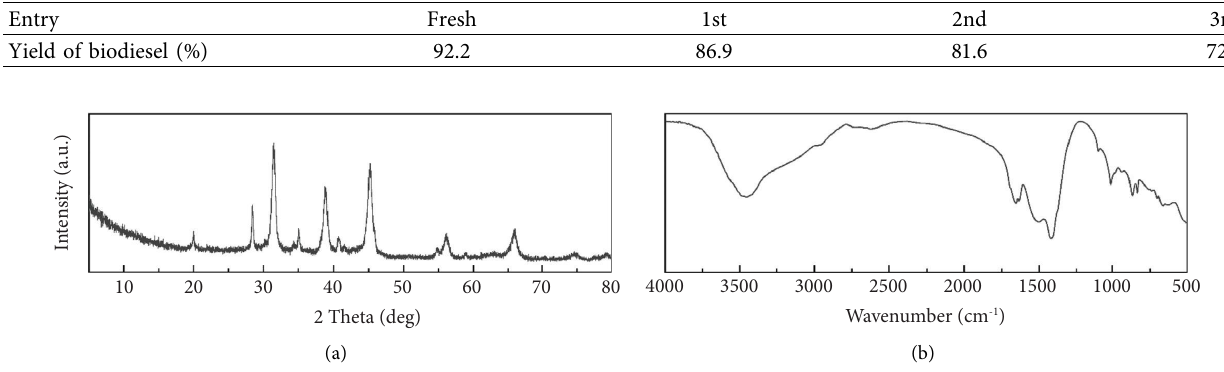
Table 1: Catalyst reusability of KF/Mg-Ca-Al HTLCs MS.